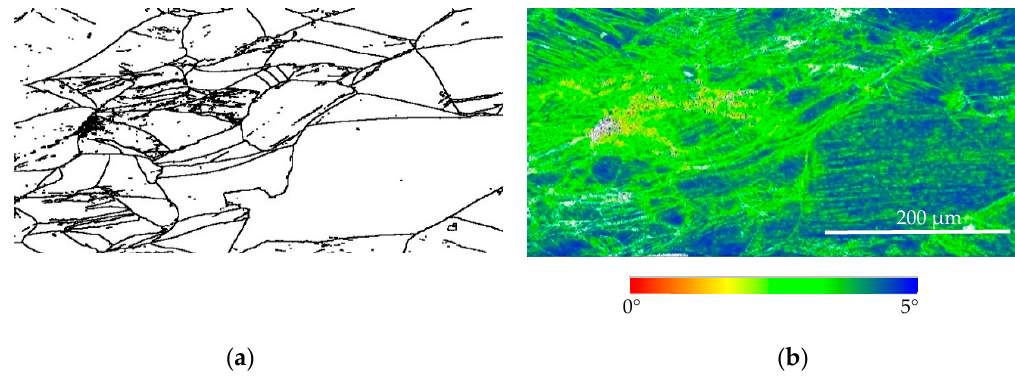
Figure 3. EBSD (electron backscattered diffraction) image of Fe-30Ni sample with initial mode grain size of 160 µm deformed to 0.3 strain at room temperature ( a ) grain boundary (HAGB > 15 degree) and ( b ) local misorientation map (misindexing, i.e., white regions, were assumed to be heavily deformed).